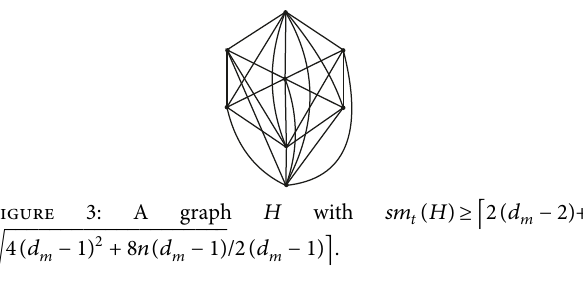
Figure 2: Illustration of NP-completeness of general